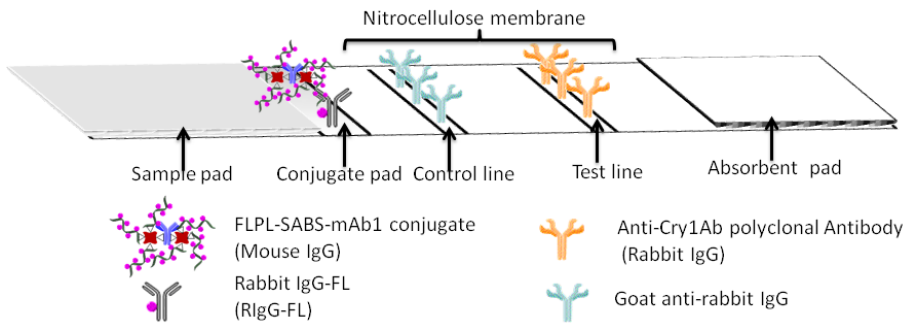
Figure 2. Schematic diagrams of FLPL-BSAS-mAb1 based